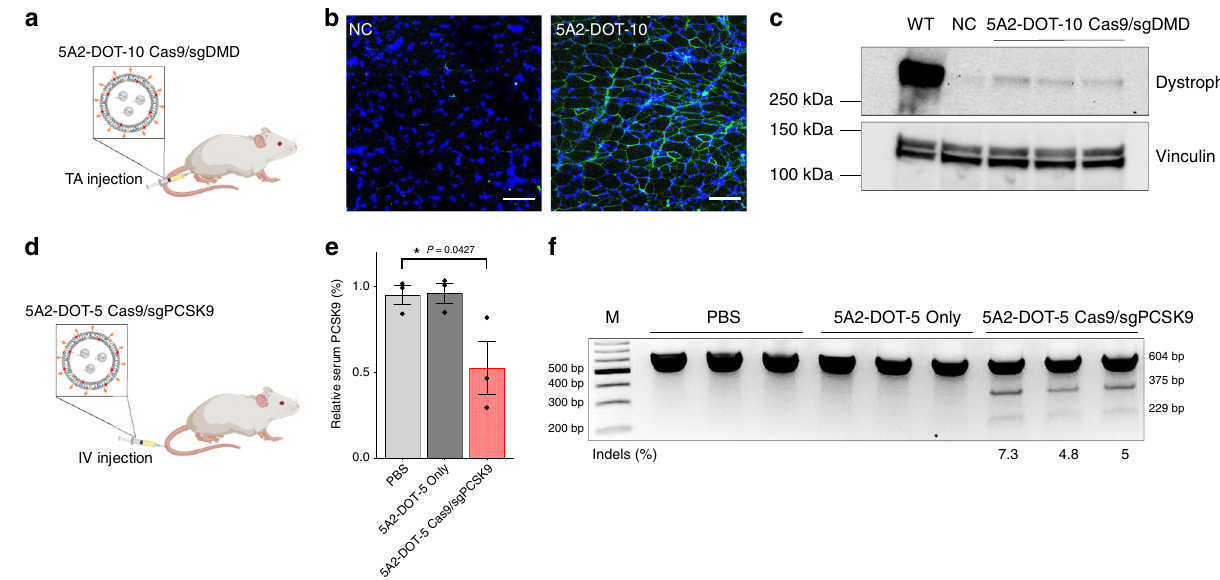
Fig. 5 5A2-DOT-X LNPs achieve CRISPR-Cas-based gene editing in therapeutic models. a To restore dystrophin expression, 5A2-DOT-10 LNPs encapsulating Cas9/sgDMD RNPs were injected into TA muscles of DMD exon 44 deletion mice weekly (three injections, 1 mg kg − 1 sgDMD, n = 3). Three weeks after the last injection, TA muscles were collected to detect expression of dystrophin protein. b Immuno fl uorescence images indicated that 5A2- DOT-10 LNPs treatment successfully corrected dystrophin gene and restored the expression of dystrophin proteins in TA muscles. 5A2-DOT-10 LNPs nanoparticle only treatment was used as negative control (NC). Scale bar = 100 μ m. Data was repeated two times independently with similar results. c Western blot analysis further con fi rmed the expression of dystrophin protein in the 5A2-DOT-10 LNPs encapsulating Cas9/sgDMD RNPs treatment group. 4.2% of dystrophin protein was restored. NC: 5A2-DOT-10 LNPs nanoparticle only; WT wild-type group. d To knockout the PCSK9 gene in mouse liver, 5A2-DOT-5 LNPs encapsulating Cas9/sgPCSK9 RNPs were administered to adult C57BL/6 mice via tail vein injection weekly (three injections, 2.5 mg kg − 1 sgPCSK9, IV, n = 3). One week after the last injection, mouse serum and livers were collected for analyses. e The relative PCSK9 level in the serum was signi fi cantly decreased in 5A2-DOT-5 LNPs encapsulating Cas9/sgPCSK9 RNPs treatment group, detected using PCSK9 Elisa Kit. Data are presented as mean ± s.e.m. ( n = 3 biologically independent animals). One-way ANOVA followed by Dunnett ’ s multiple comparison test was used to determine the signi fi cance of data. (* P < 0.05). f T7EI cleavage results from genomic DNA extracted from mice livers con fi rmed gene editing occurred at the PCSK9 locus. Red arrows indicate cleavage bands. Indel percentages shown under the gel image were measured by Sanger sequencing and TIDE analysis. Source data are in the Source Data fi